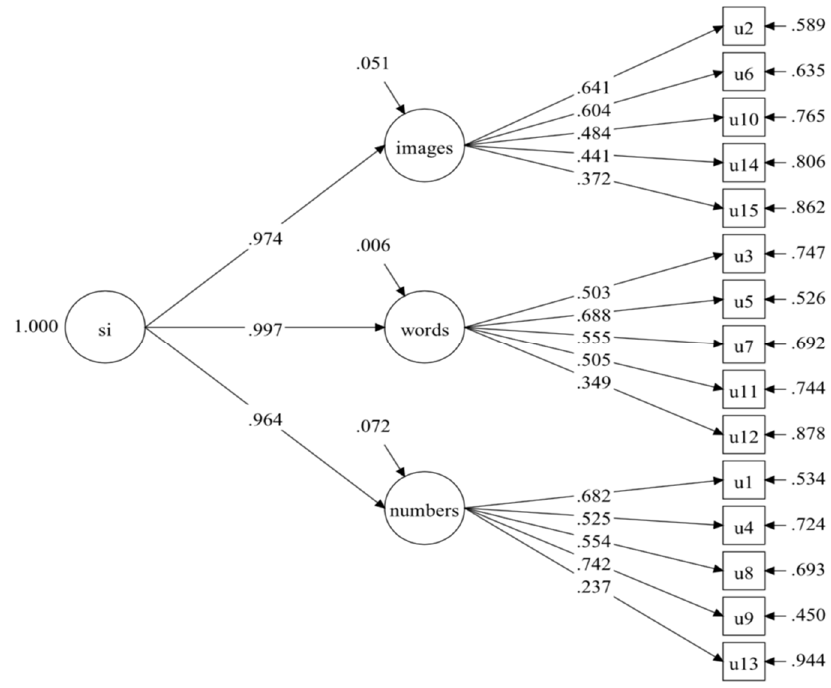
Figure 1. Model 1: one general factor of three domains. Notes. u1 = Story Problems, u2 = Floating Boats, u3 = Metaphors, u4 = Number Cards (Letter Math), u5 = Words That Sound the Same (Homophones), u6 = Paper Cutting, u7 = Decisions, u8 = Maps, u9 = Exchange, u10 = Toy Shadows, u11 = Interesting (Figurative) Language, u12 = Conversations, u13 = Number Talk, u14 = Multiple Uses, u15 = Book Covers.